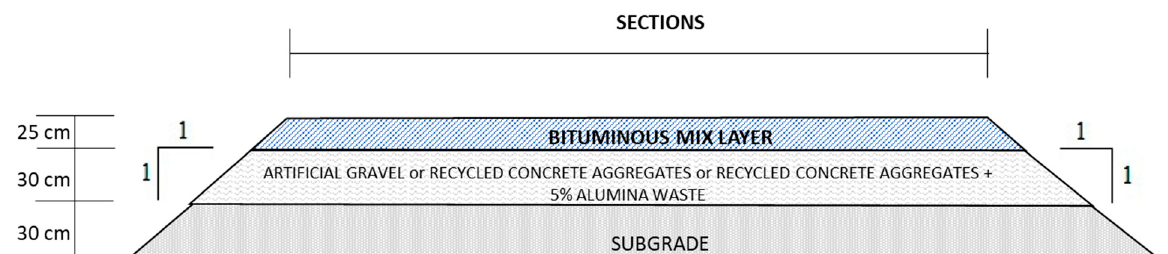
Figure 2. Structural layers of the road sections.